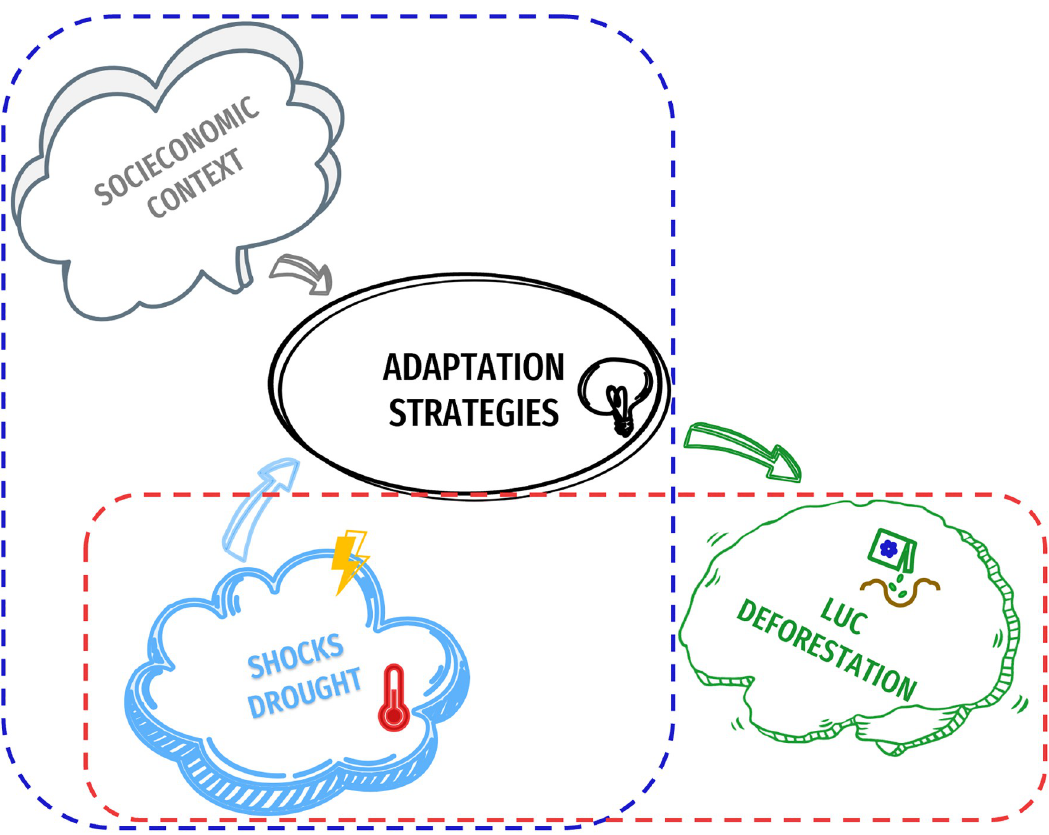
Fig 1. The two sets of empirical literature on droughts, adaptation and land-use